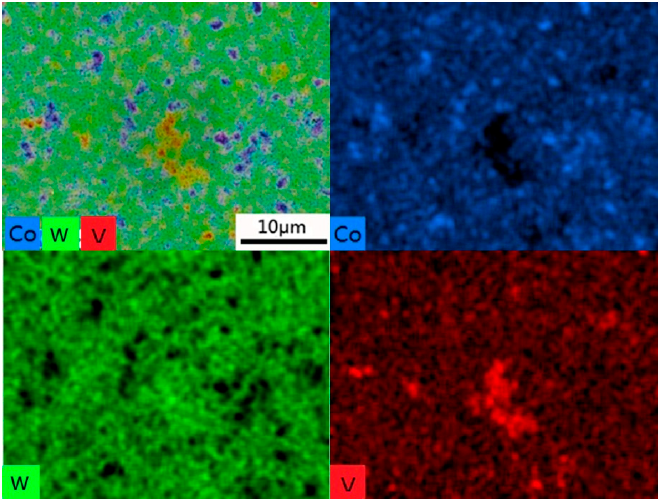
Figure 5. Energy dispersive spectroscopy (EDS) elemental mapping of sample A2 with 0.8 wt. % Cr 3 C 2 .